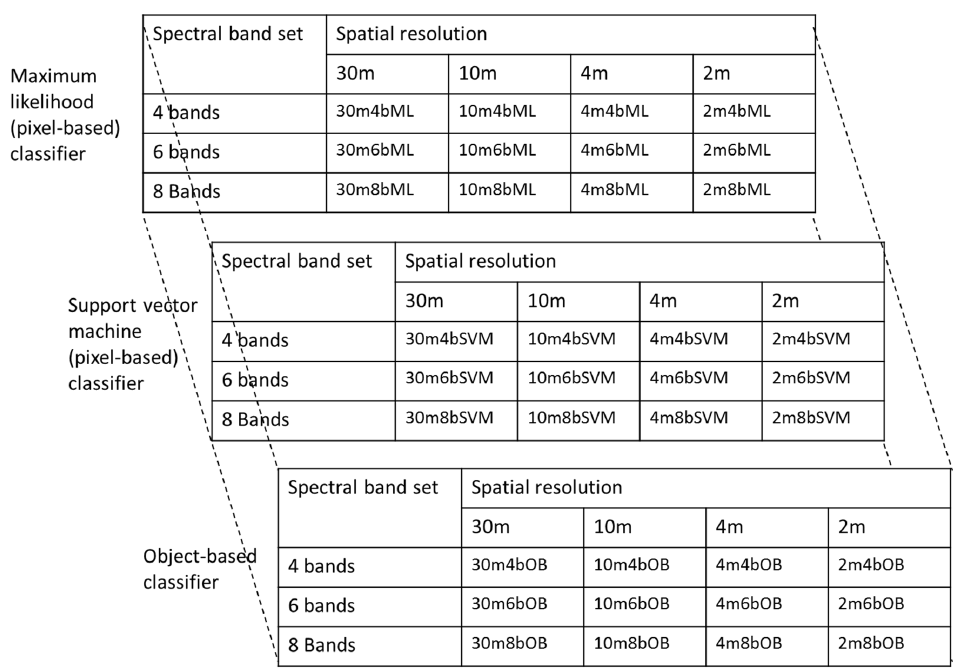
Figure 3. The 36 image data set/classifier combinations (4 spatial resolutions × 3 spectral band sets × 3 classifiers) used for comparative classification analysis.